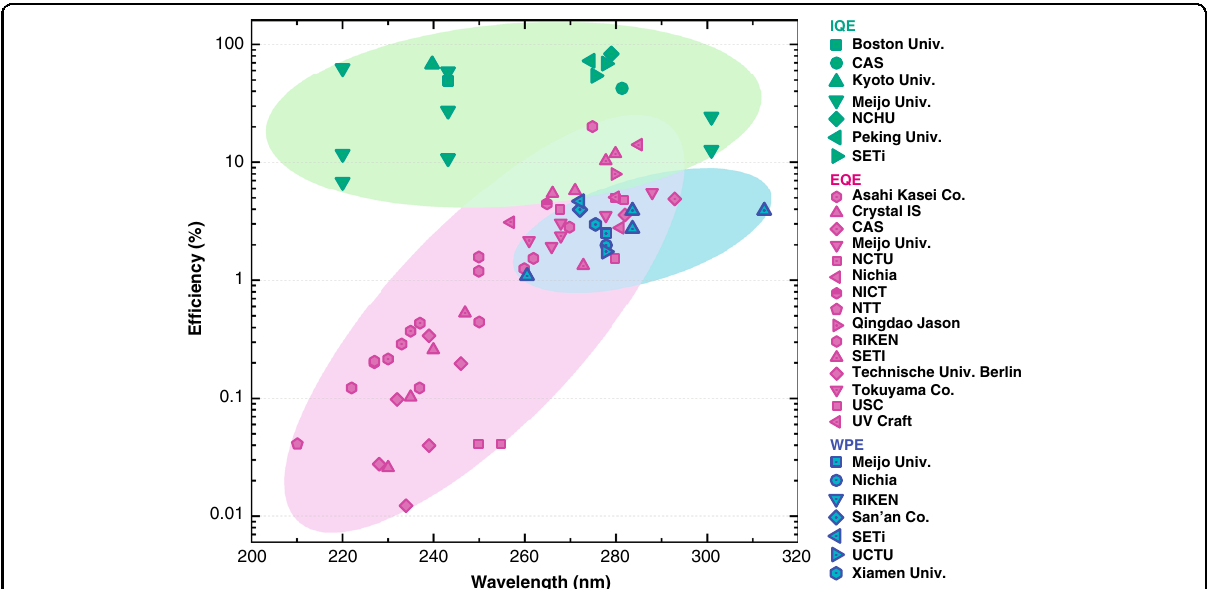
Fig. 14 EQEs (pink dots), WPEs (blue dots) and IQEs (green dots) for commercial and laboratorial DUV LEDs. Data points obtained from refs. 24,25,28,29,31,32,52,56,106,112,131,164,177 – 192